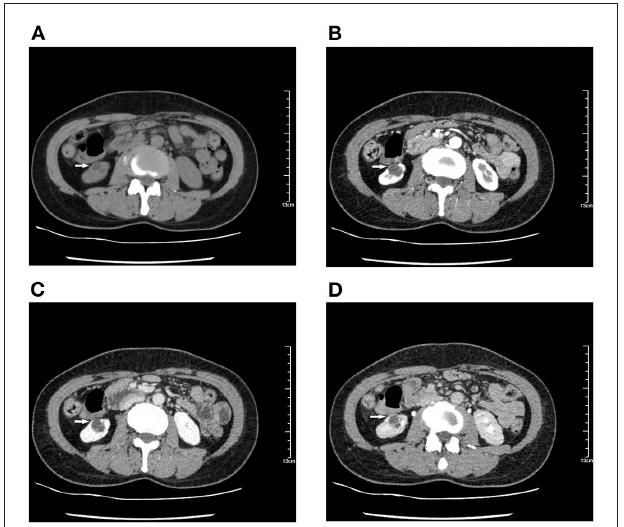
FIGURE 1 | Computed tomography (CT) shows a hypodense mass of 1.8 × 1.5 × 1.4cm in the lower pole of the right kidney. Contrast-enhanced CT scan shows a polycystic mass with slight enhancement of the wall and septa and no enhancement in the cystic part. The right lower pole of the kidney is partially depressed, and contrast-enhanced images show local thinning of the renal cortex during cortical enhancement. (A) Unenhanced images. (B–D) With contrast. (B) Renal cortical phase. (C) Renal corticomedullary phase. (D) Renal excretory phase.